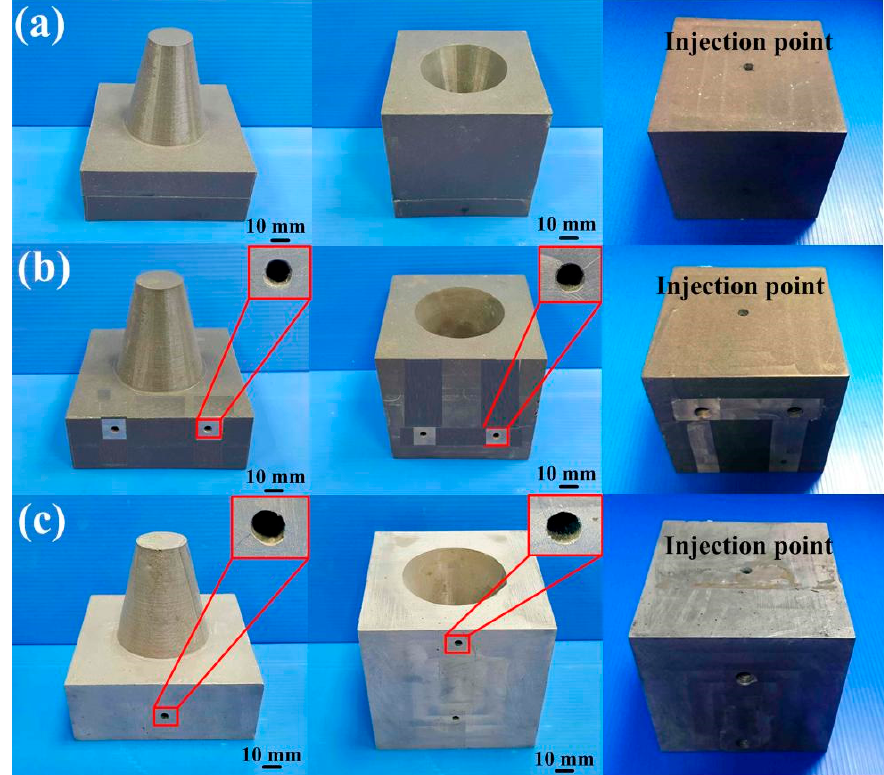
Figure 17. Accomplished injection molds ( a ) without cooling channel, ( b ) with conventional cooling channels, and ( c ) with optimum CCCs.